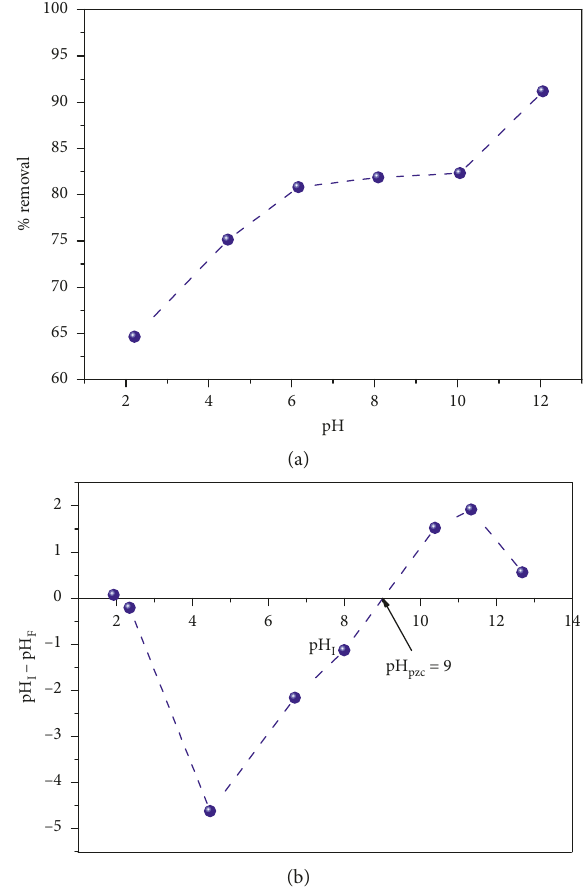
Figure 5: Effect of pH on adsorption of MB onto geopolymer (a) and point of zero charge (pH pzc ) of geopolymer